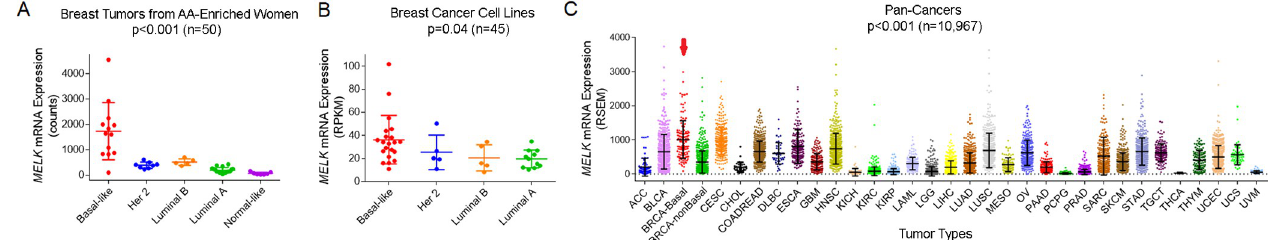
Fig 1. Increased expression of MELK mRNA in Basal-like breast cancer. (A) Subtype-specific expression of MELK mRNA was identified using RiboZero RNA-sequencing in breast tumors (n = 50) from women of diverse ethnicities including 66% of African Americans (AA). (B). MELK mRNA expression was determined in 45 breast cancer cell lines using the CCLE dataset. (C) MELK 1 expression was analyzed using the Pan-Cancer RNA-Seq dataset. The arrow indicates MELK expression from basal-like breast tumors (BRCA-Basal) compared to non-Basal subtypes of breast cancer (BRCA-non-Basal) and other cancers. ACC, Adrenocortical Carcinoma; BLCA, Bladder Urothelial Carcinoma; BRCA, Breast Invasive Carcinoma; CESC, Cervical Squamous Cell Carcinoma and Endocervical Adenocarcinoma; CHOL, Cholangiocarcinoma; COADREAD, Colon Adenocarcinoma & Rectum Adenocarcinoma; DLBC, Lymphoid Neoplasm Diffuse Large B-cell Lymphoma; ESCA, Esophageal Carcinoma; GBM, Glioblastoma Multiforme; HNSC, Head and Neck Squamous Cell Carcinoma; KICH, Kidney Chromophobe; KIRC, Kidney Renal Clear Cell Carcinoma; KIRP, Kidney Renal Papillary Cell Carcinoma; LAML, Acute Myeloid Leukemia; LGG, Brain Lower Grade Glioma; LIHC, Liver Hepatocellular Carcinoma; LUAD, Lung Adenocarcinoma; LUSC, Lung Squamous Cell Carcinoma; MESO, Mesothelioma; OV, Ovarian Serous Cystadenocarcinoma; PAAD, Pancreatic Adenocarcinoma, PCPG, Pheochromocytoma and Paraganglioma; PRAD, Prostate Adenocarcinoma; SARC, Sarcoma; SKCM, Skin Cutaneous Melanoma; STAD, Stomach Adenocarcinoma; TGCT, Testicular Germ Cell Tumors; THCA, Thyroid Carcinoma; THYM, Thymoma; UCEC, Uterine Corpus Endometrial Carcinoma; UCS, Uterine Carcinosarcoma; UVM, Uveal